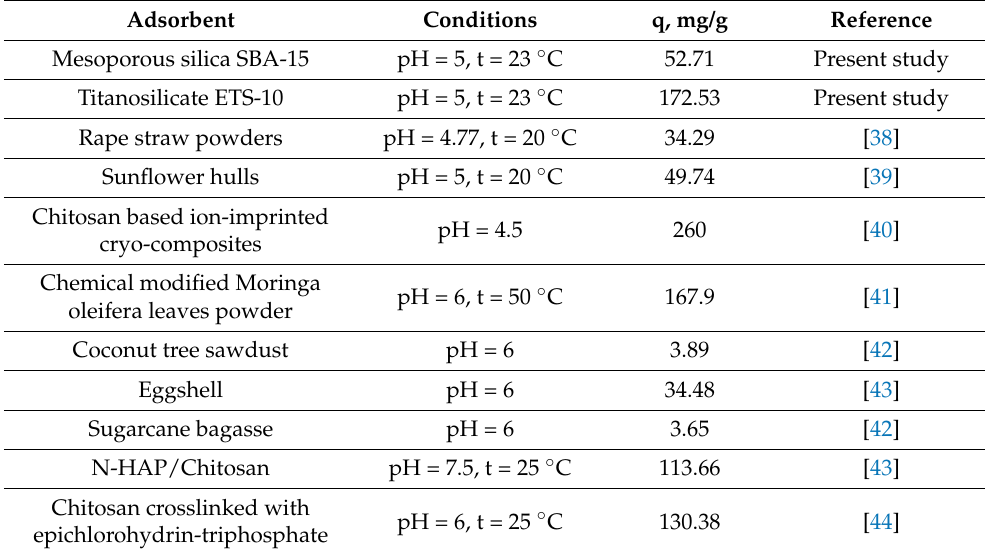
Table 2. The comparison of maximum sorption capacity of Cu(II) ions onto different adsorbents.